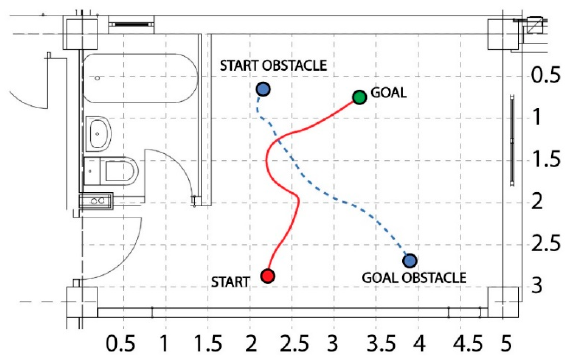
Figure 14. Dynamic obstacle avoidance.